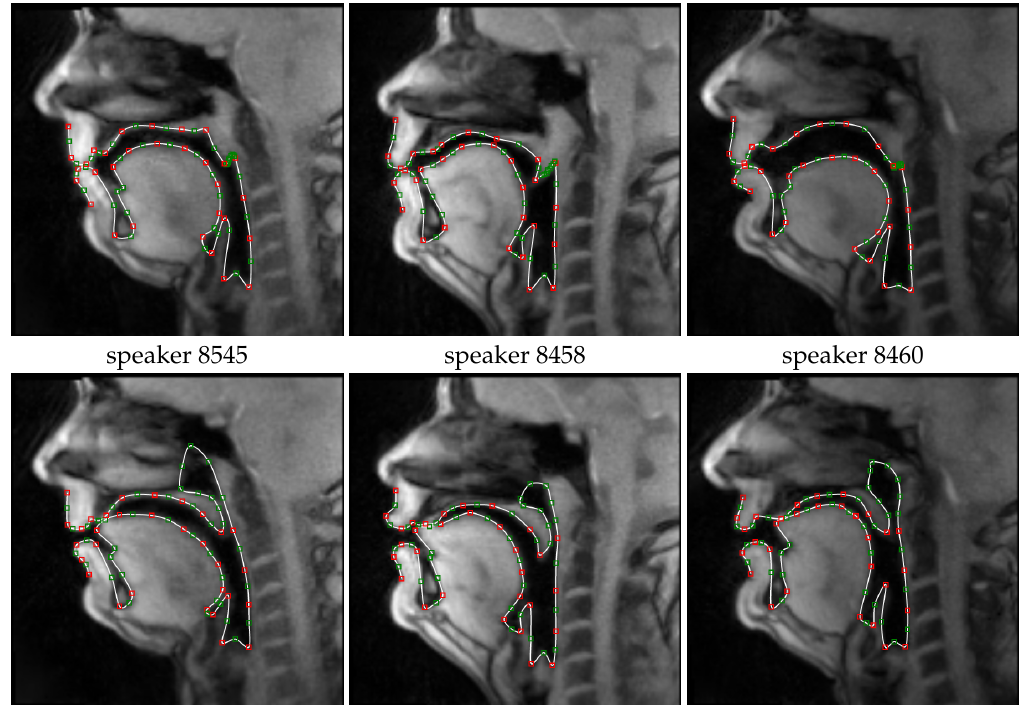
Figure 4. Illustrative examples of the automatically segmented vocal tract contours represented over the corresponding midsagittal real-time MRI images for three speakers uttering /p/, on the top row, and /n/ on the bottom